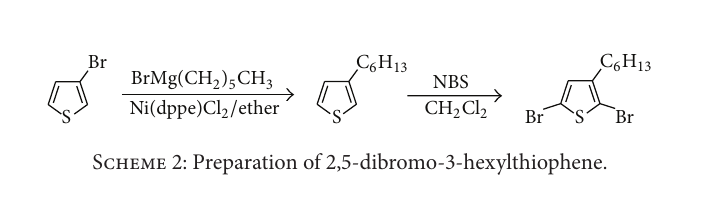
Scheme 1: Representative synthetic routes for P3HT.